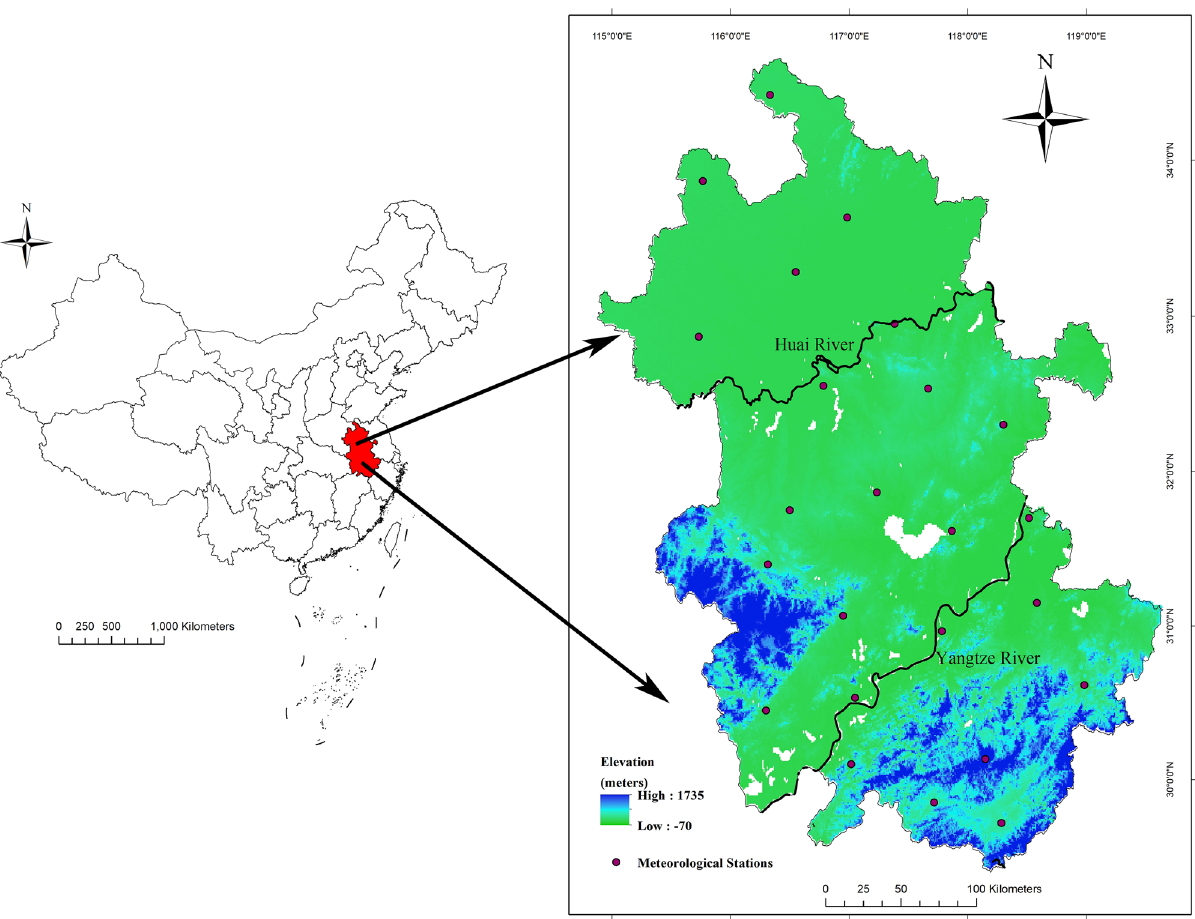
Figure 1. The geographic location and the color altitude map of Anhui province. Geographical distribution of 24 meteorological stations (purple dots) where meteorological data were acquired for this study. The base layer of the map was obtained from Resource and Environment Science and Data Center (https:// www. resdc. cn/ Datal ist1. aspx? Field TyepID=